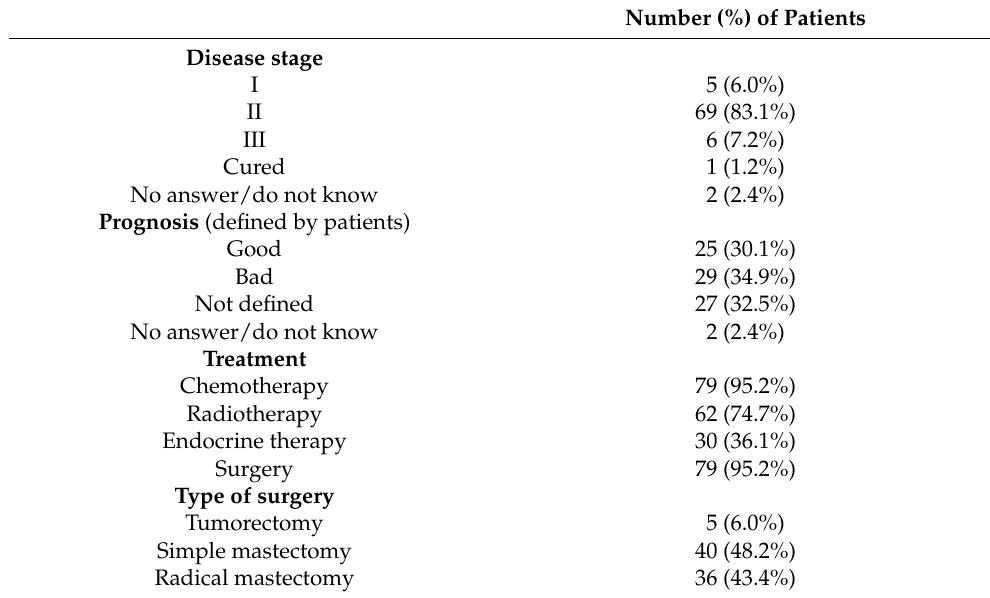
Table 2. Clinical characteristics of the sample ( n =